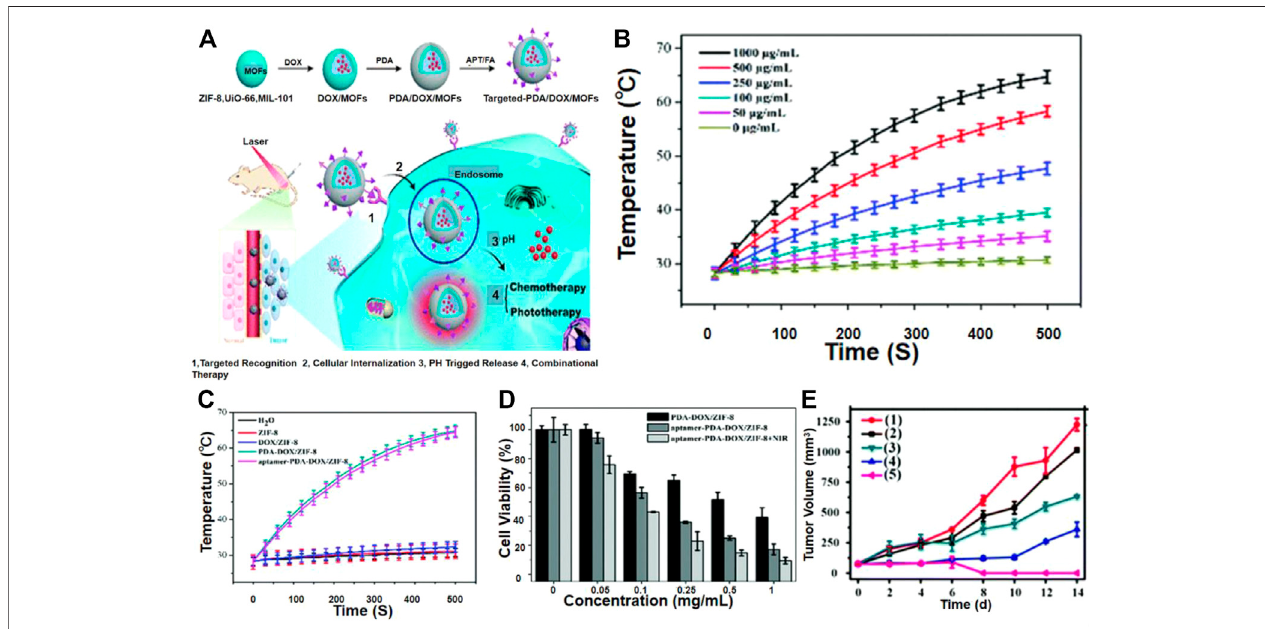
FIGURE 8 | (A) Schematic MOFs as combinational therapy. (B) Heating curve of different concentrations of sgc-8-PDA-DOX/ZIF-8. (C) Heating curve of various componentsofPDA-DOX/ZIF-8. (D) ViabilityofHeLacellswithvariousconcentrationsofPDA – DOX/ZIF-8andsgc-8 – PDA – DOX/ZIF-8inthepresenceorabsenceof808 nm irradiation. (E) The change curve of tumor volume in mice after different treatments. Reproduced with permission (Feng et al., 2019). Copyright 2019, J. Mater. Chem. B.